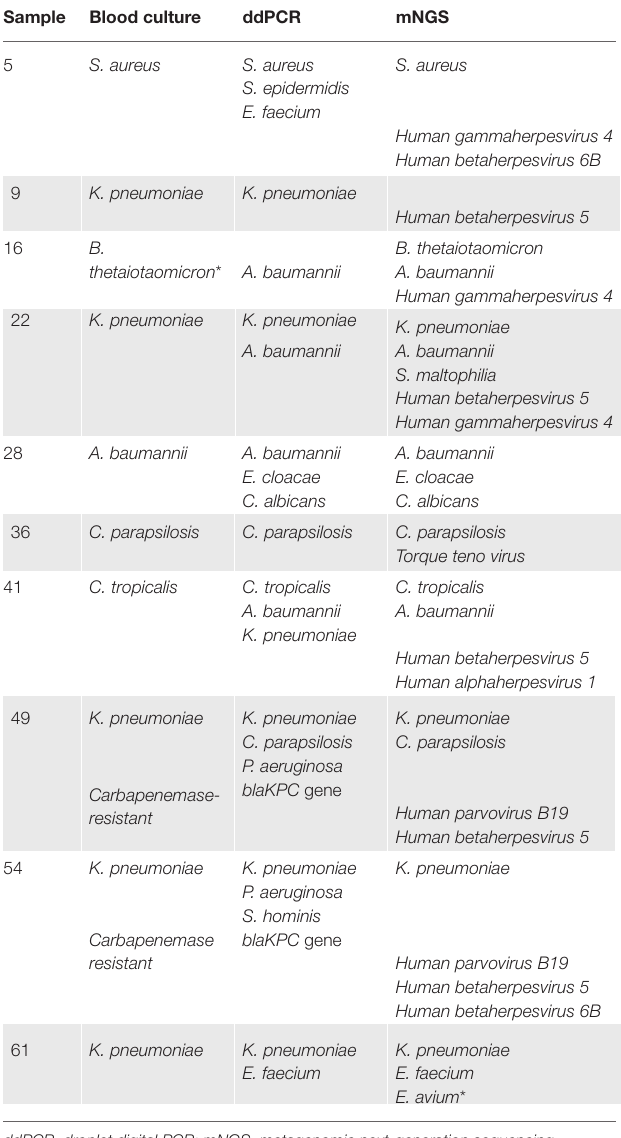
TABLE 2 | Comparison of pathogen detection among the ddPCR, mNGS, and blood culture methods in patients with positive blood culture. Sample Blood